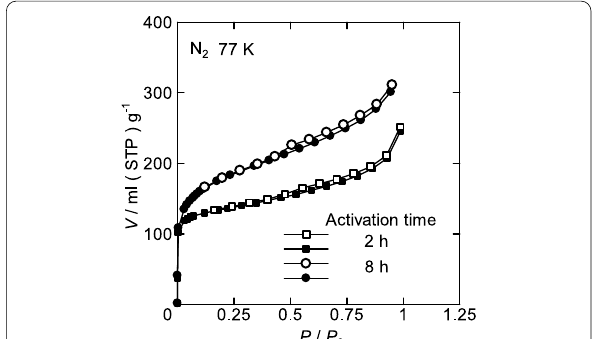
Fig. 3 Pore distribution curves for mesopores of activated tunicate cellulose (TC) carbons. V p and R p indicate pore volume and pore size, respectively